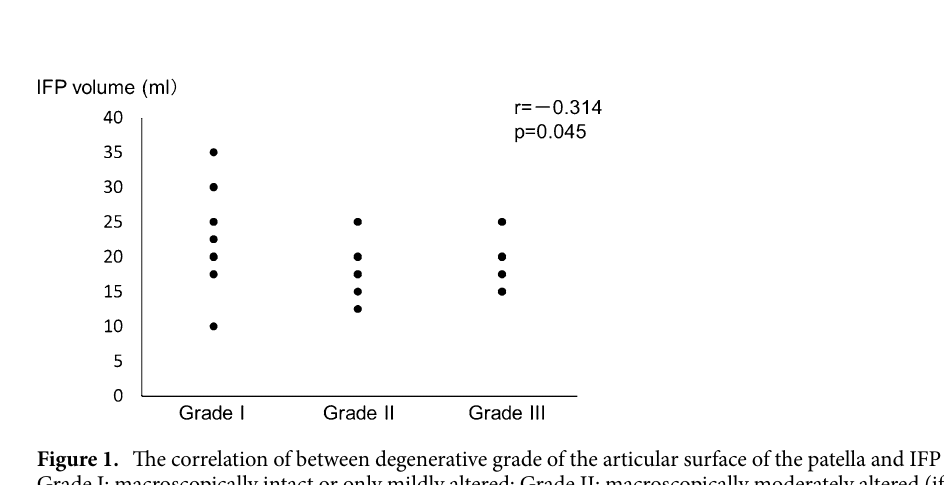
Table 3. Relationship between degenerative grade of articular surface of patella and IFP. Values represent number of specimens (%). a p = 0.003 vs. grade I and grade III. b p = 0.003 vs. grade I and grade III. c p = 0.003 vs. grade I and grade II.